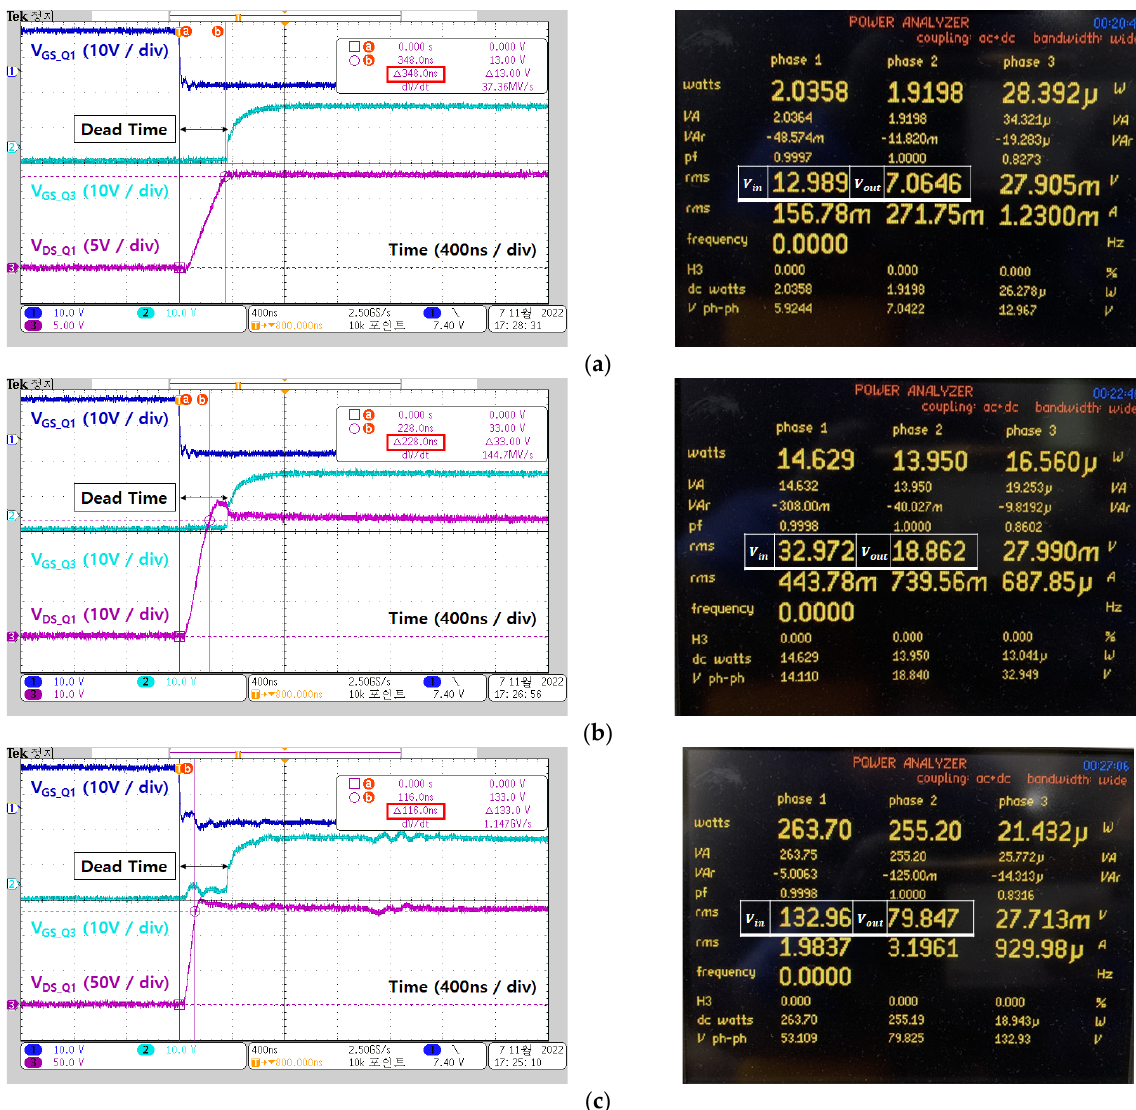
Figure 10. Experimental waveforms and input–output voltage: ( a ) input voltage 13 V; ( b ) input voltage 33 V; ( c ) input voltage 133 V.